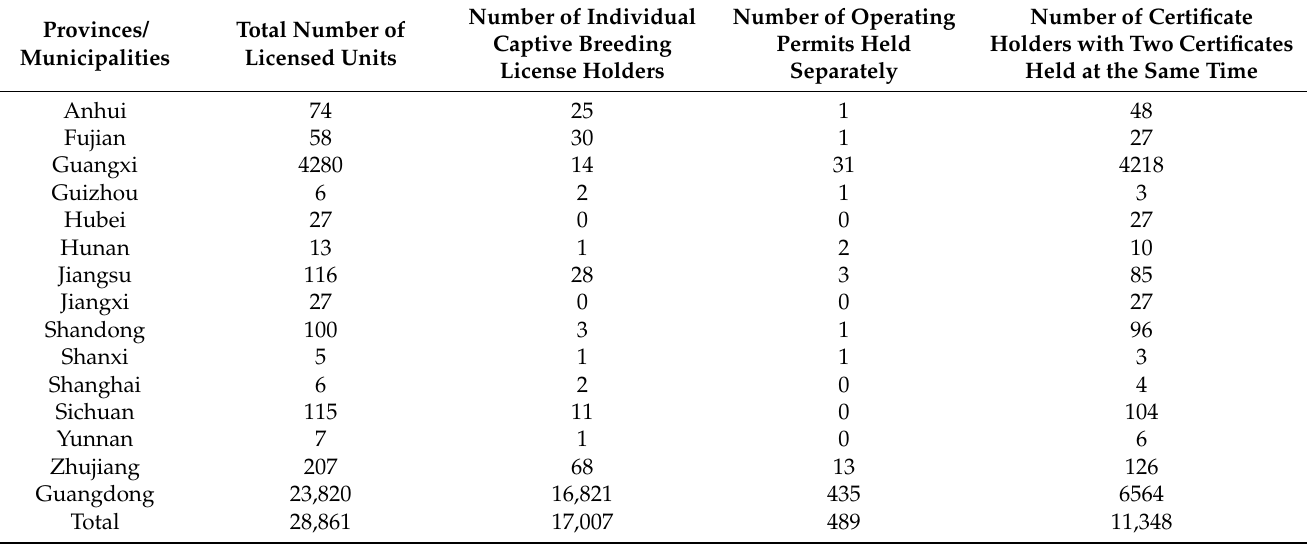
Table 2. Number of certificate holders in the provinces/municipalities